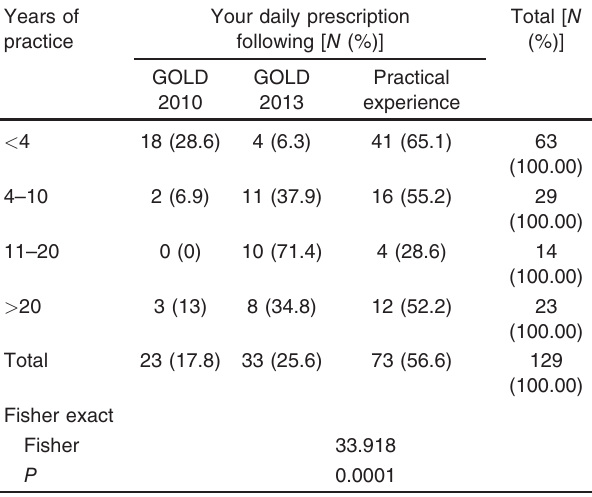
Table 13 Relation between doctors ’ years of practice and daily prescription following GOLD